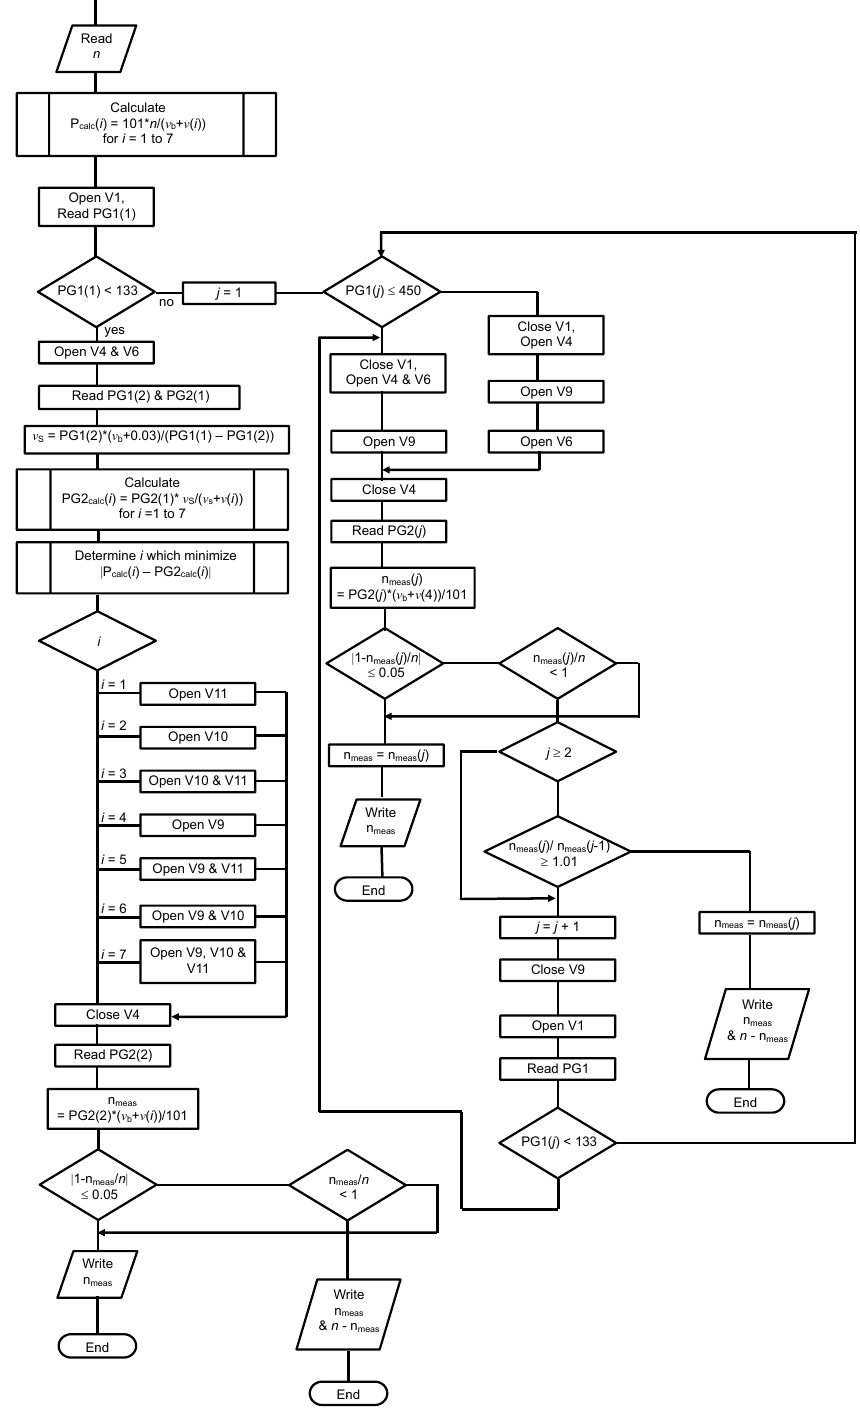
Figure 3. Flow chart of the algorithm for sample injection. n denotes the sample size in cubic centimeters at 25 ◦ C and 1atm. n meas or n meas (j) is the actual sample size calculated from measured pressure. v b is the partial volume (cm 3 ) of the vacuum line indicated by B in Fig. 1. v(i) is the calibrated volume that corresponds to the sample expanding option i . v S is sum of the volume of sample flask and partial volume A. PG1( j) and PG2( j) are outputs of pressure gauges 1 and 2 (in kPa) (Fig. 1). P calc (i) and PG2 calc (i) are calculated pressures that correspond to the sample expanding option i